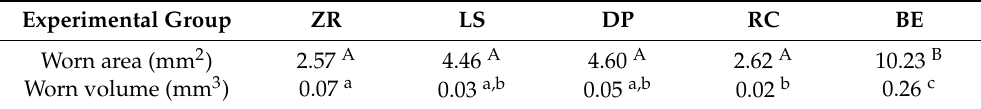
Table 5. Median of worn area and volume of the substrate